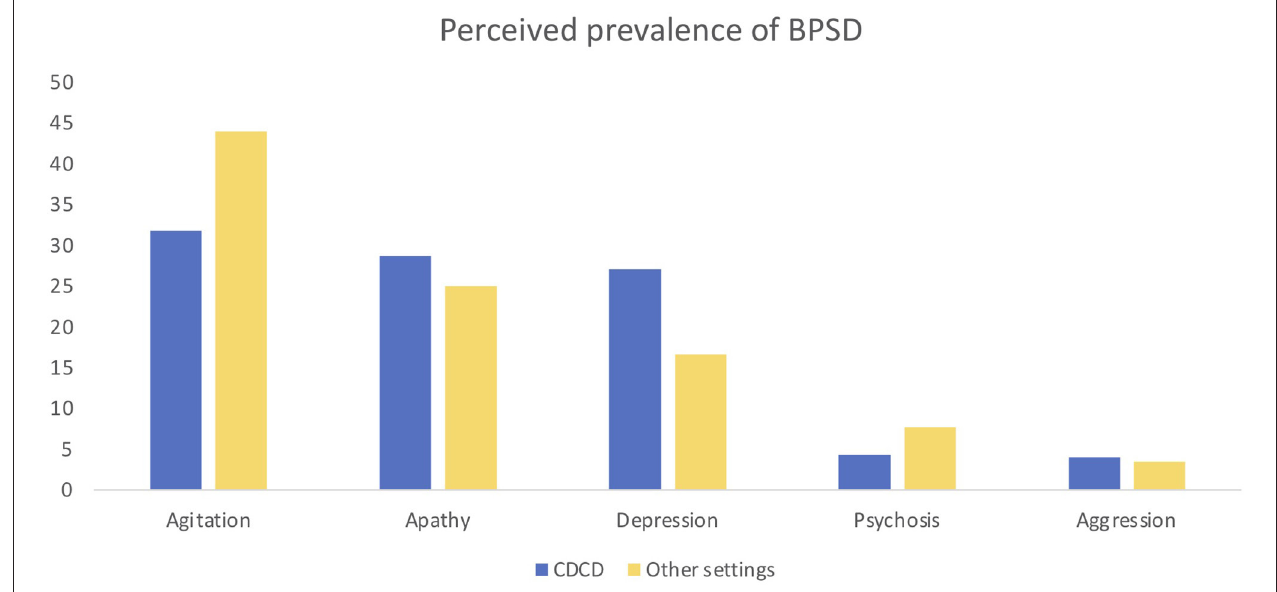
FIGURE 1 | Answer differences between CDCD and non-CDCD setting: perceived prevalence of